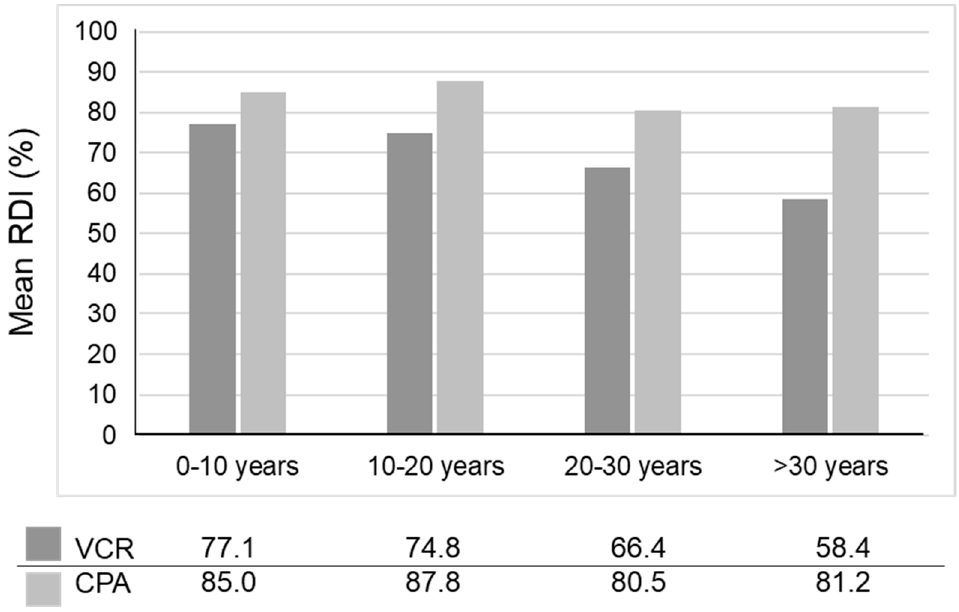
Figure 2. Relative dose intensity of vincristine and cyclophosphamide in relation to age. The relative dose-intensity of vincristine and cyclophosphamide tended to decrease as the patients aged. CPA, cyclophosphamide; RDI, relative dose intensity; VCR, vincristine. This figure was used with the permission of Kojima et al. [35]. Table 1. Comparison of the mean relative dose-intensity between adults and children.